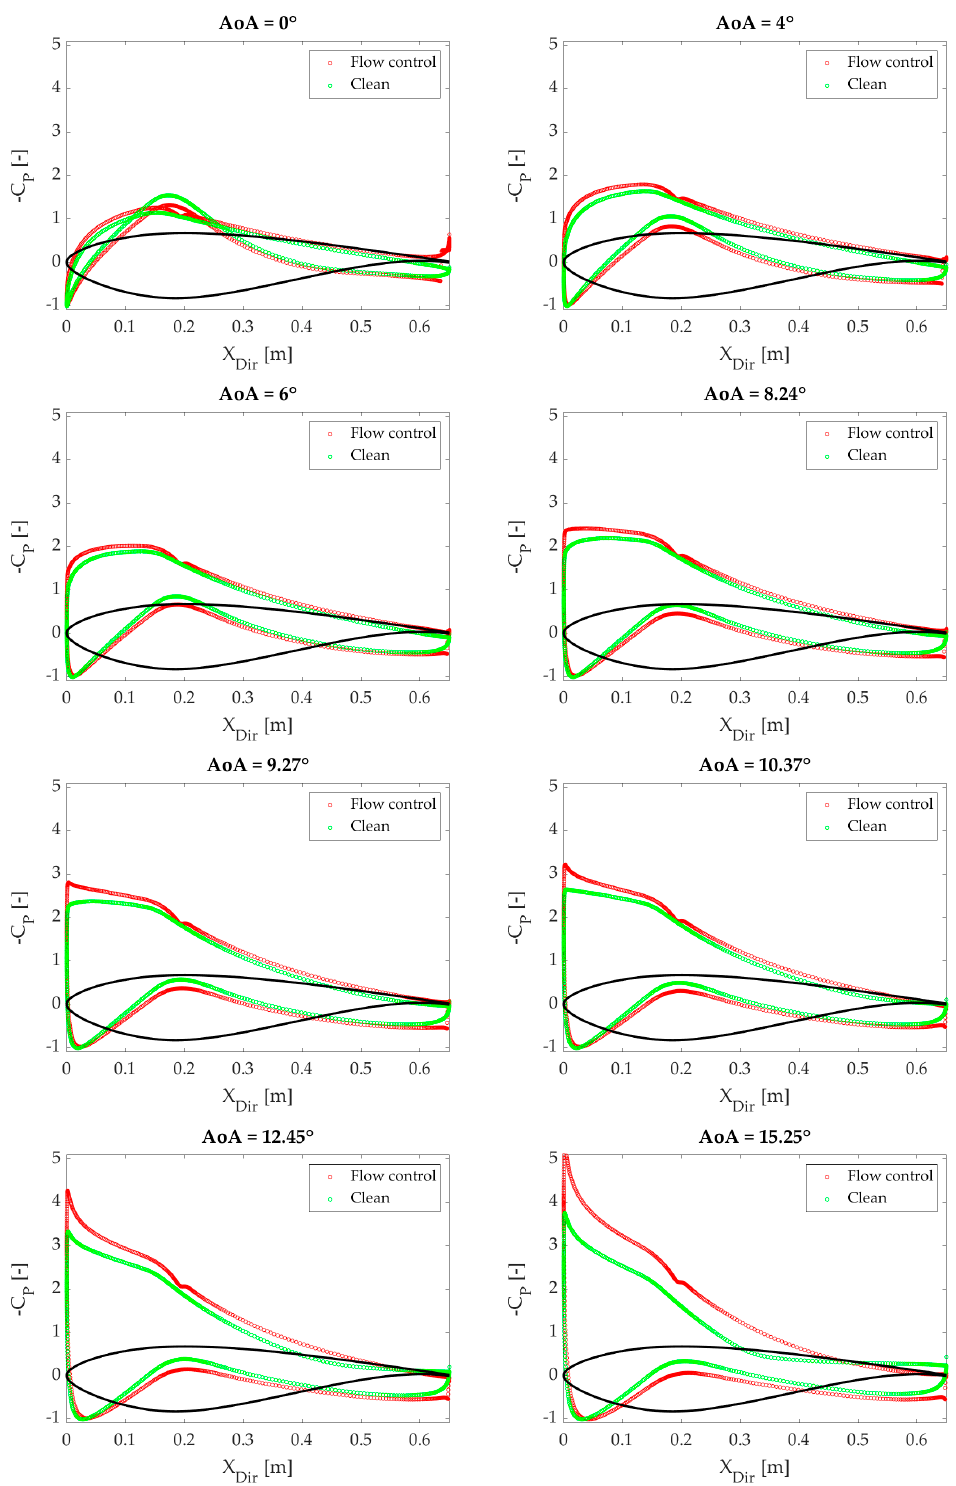
Figure A1. C P pressure coe ffi cient values from 0 ◦ to 15.25 ◦ of AoA on the DU97W300 airfoil. Green circles represent the values reached without flow control devices. Red circles show the pressure coe ffi cients (C P ) for a DU97W300 airfoil with flow control devices (triangular VG and optimum